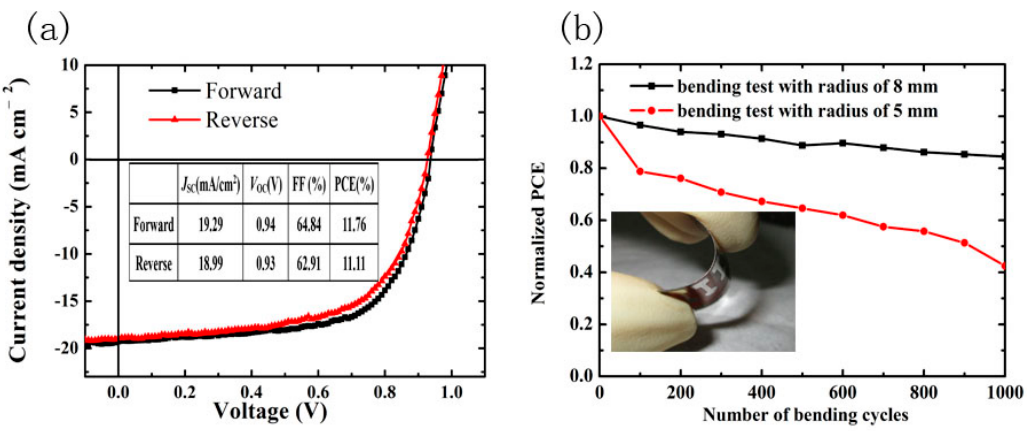
Figure 8. ( a ) J - V characteristics of forward and reverse bias sweeps for the best-performing flexible PSCs; ( b ) Normalized PCE of flexible perovskite devices as a function of bending cycles with different radii of 8 and 5 mm. Inset is a photograph of the flexible device.